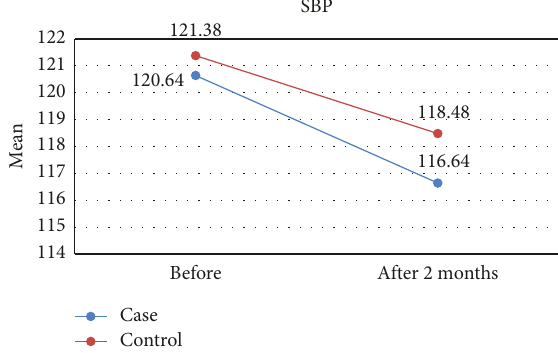
Figure 4: Effect of lycopene supplementation on TC levels.